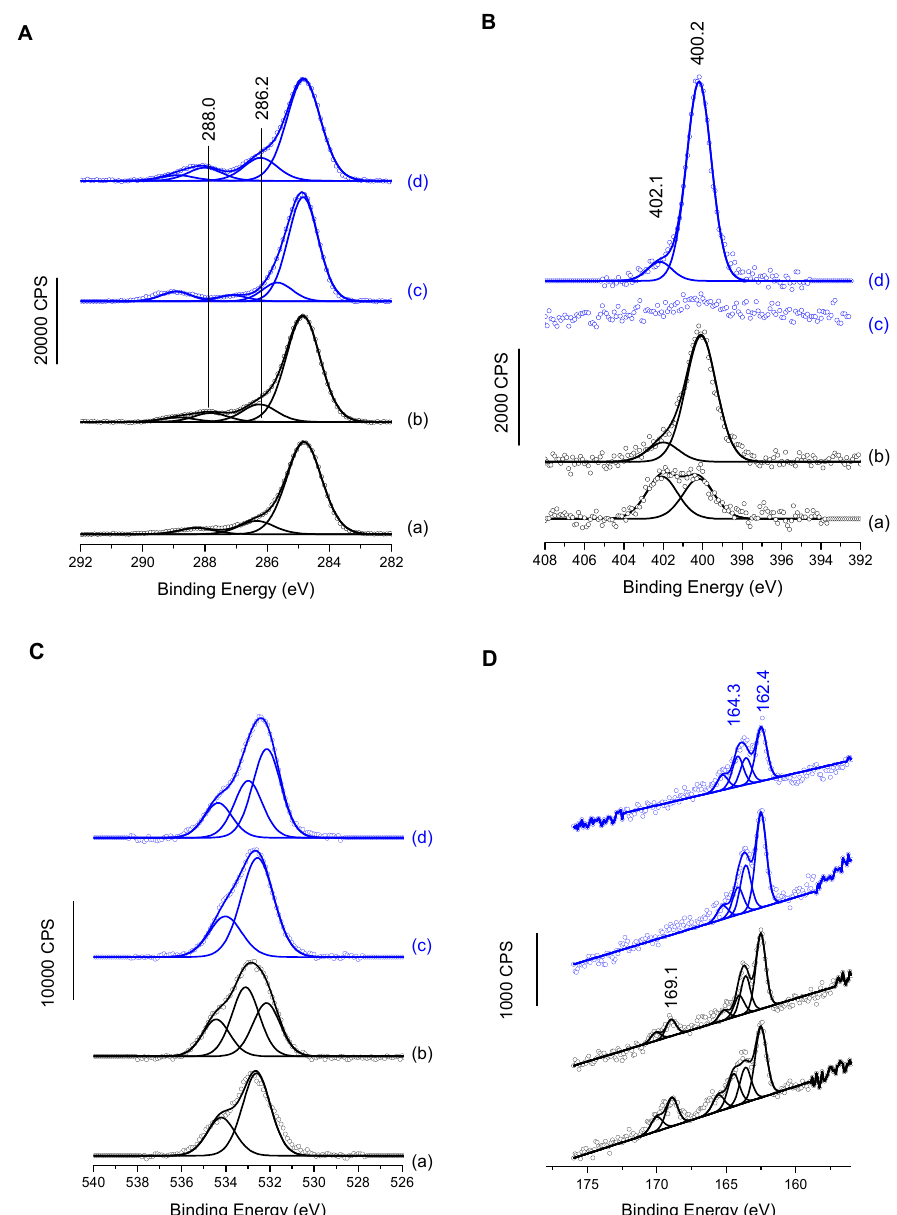
Figure 3. High resolution XPS spectra of gold surfaces functionalized with (a) MUAM, (b) MUAM-[K 3 ]SHa-COOH, (c) MUA and (d) MUA-[K 3 ]SHa for ( A ) the C1s region, ( B ) the N1s region, ( C ) the O1s region and ( D ) the S2p region. Table 2. Atomic percentage composition of functionalized surfaces obtained from XPS data presented in Figure 3.